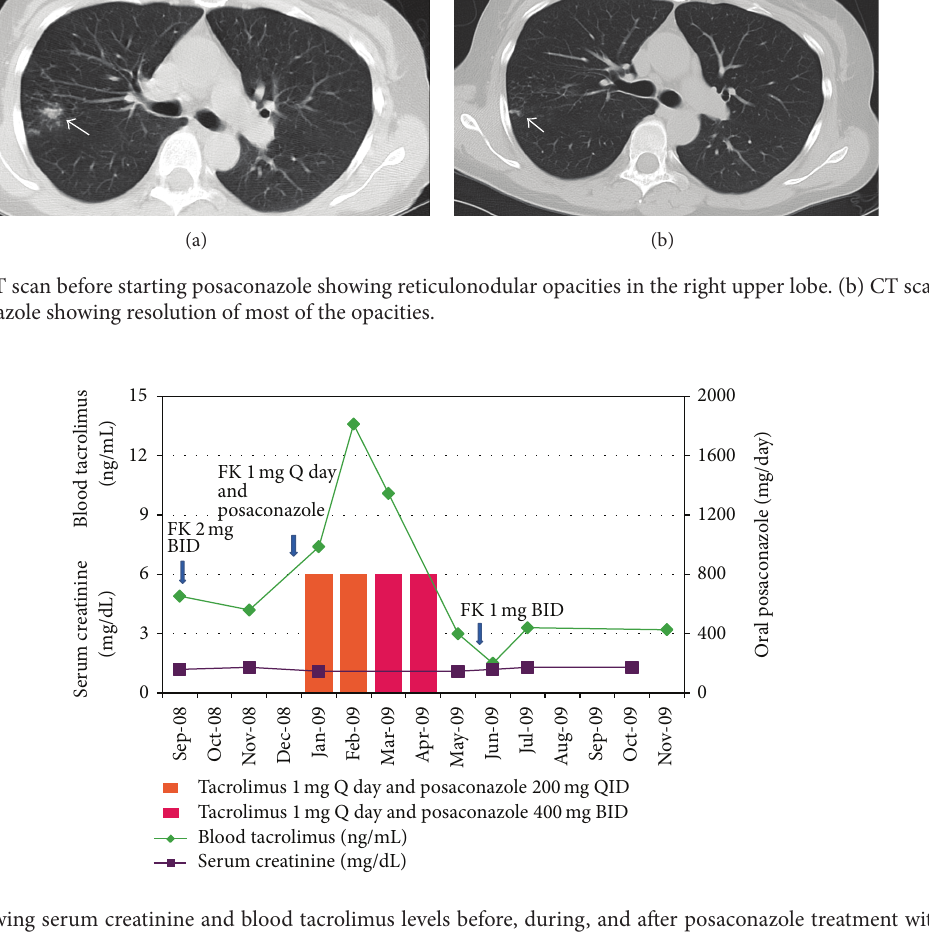
Figure 2: Graph showing serum creatinine and blood tacrolimus levels before, during, and after posaconazole treatment with tacrolimus dose